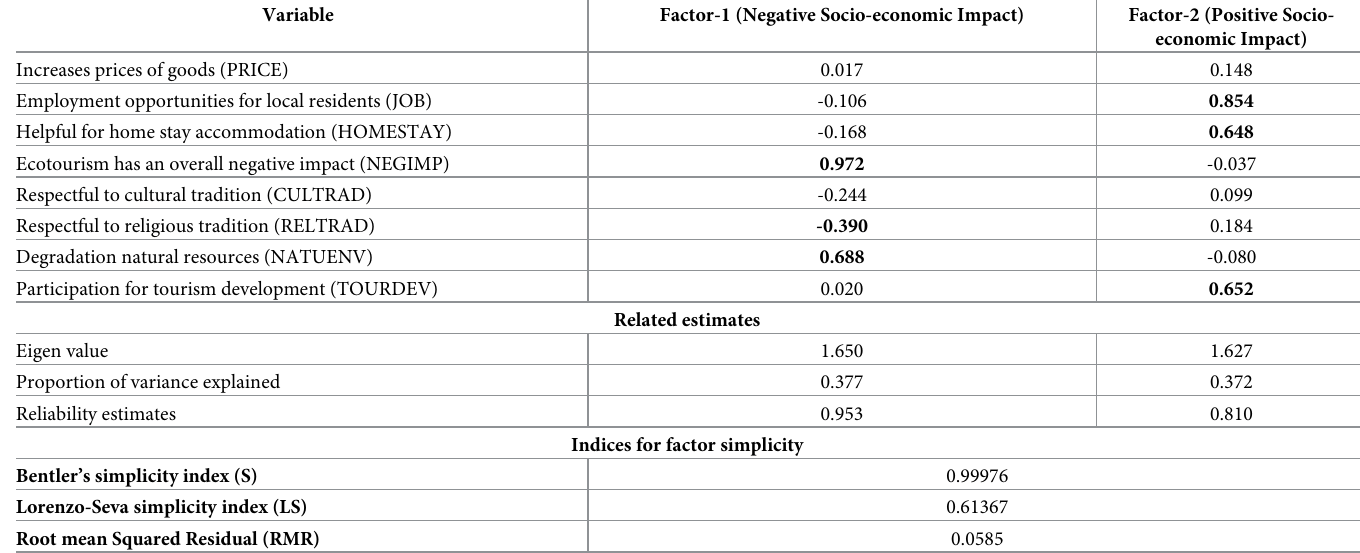
Table 4. Results of factor